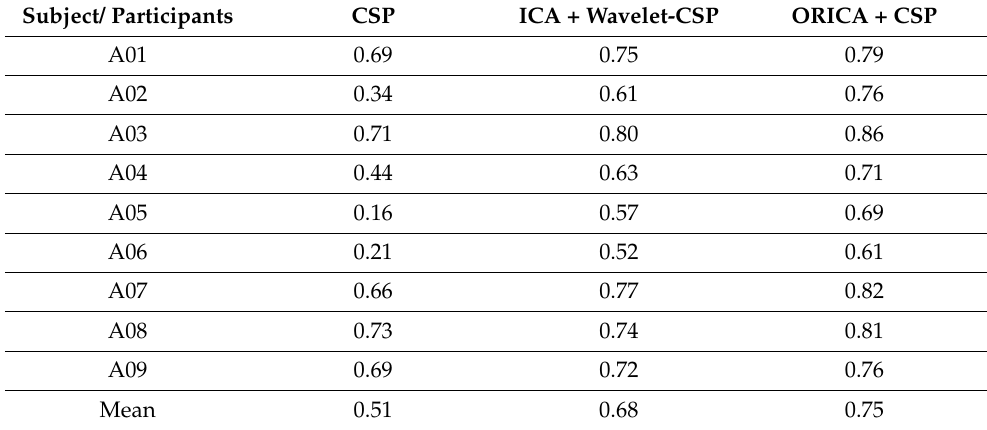
Table 2. Performance comparison of every participant in terms of Cohen’s Kappa